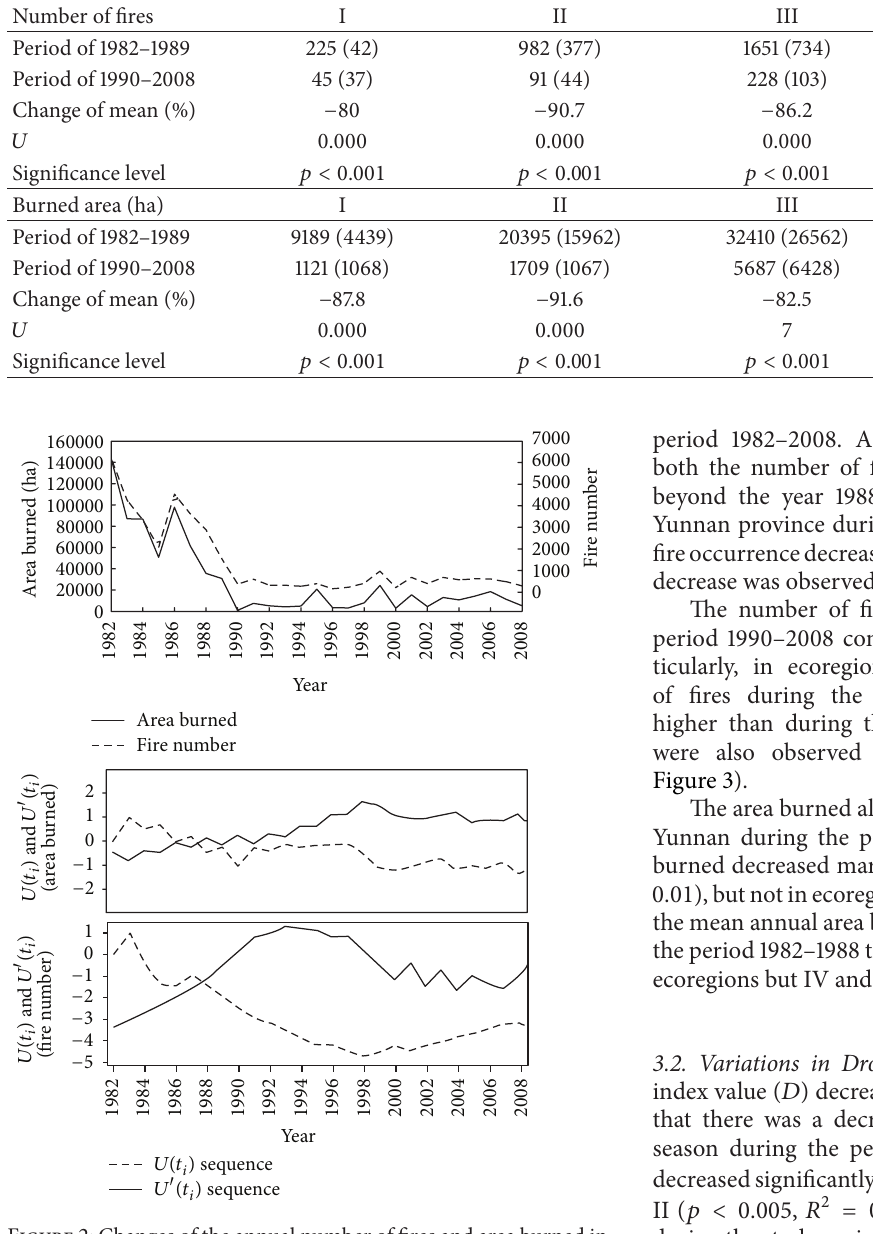
Figure 2: Changes of the annual number of fires and area burned in Yunnan province during the period